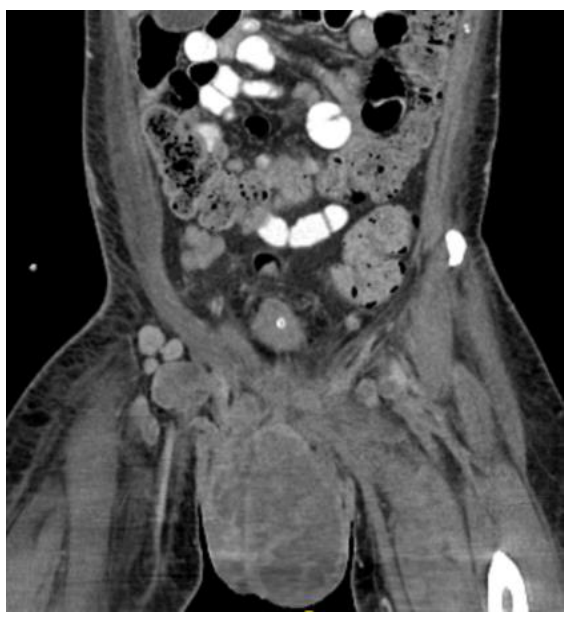
Figure 7. CT in the coronal view of scrotal mass in the right inguinal lymph node.